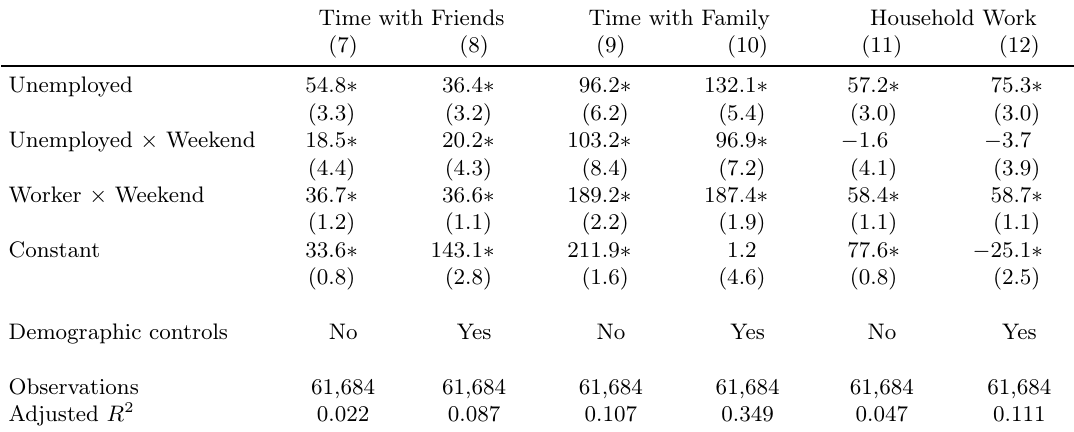
Table 3: Determinants of Time Use: Friends, Family and Housework Time with Friends